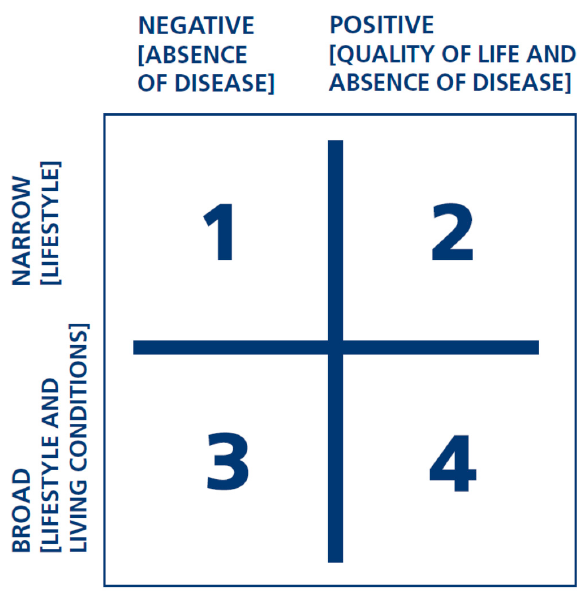
Figure 1 . Four different health concepts. Figure 1. Four different health